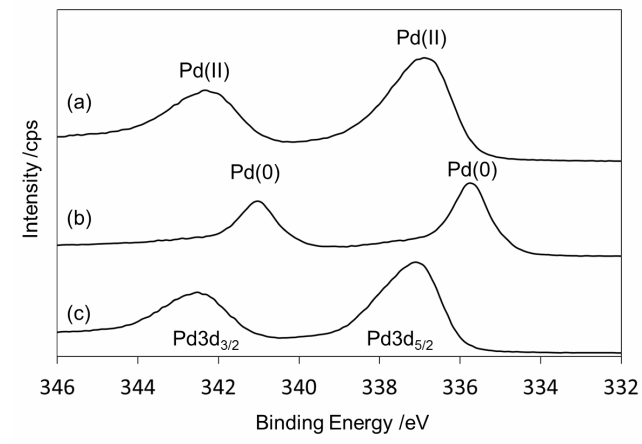
Figure 3. XPS spectrum of the Pd 3d region of the catalyst: ( a ) PS-PdONPs; ( b ) after treatment with acrylic acid; ( c ) after treatment with styrene.